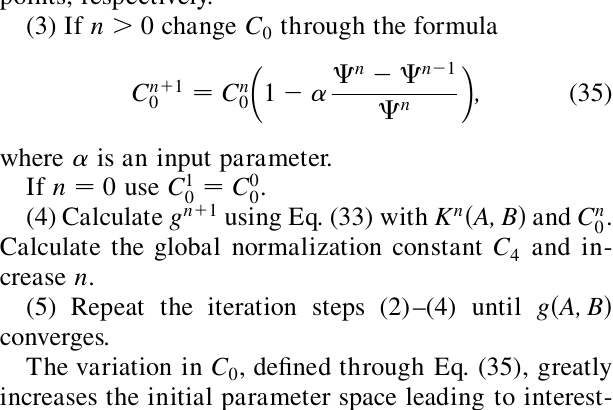
and the soliton 0